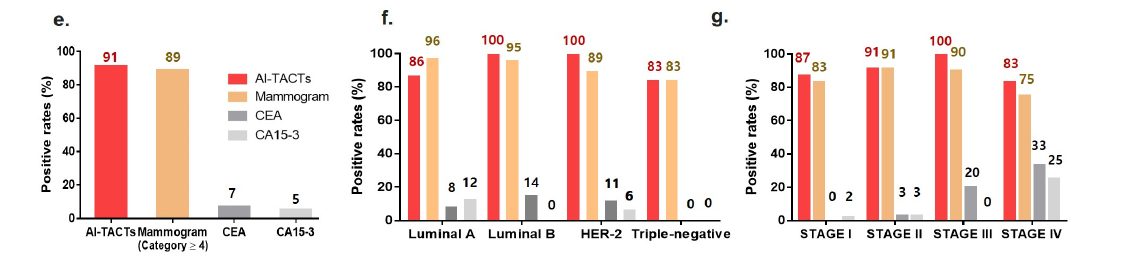
Figure 3. Modeling classifiers and validation of the TACT assay in healthy controls and breast can ‐ cer patients. ( a ) Optimization of artificial intelligence analyses (decision tree (DT), logistic regression (LR), artificial neural network (ANN), and support vector machine (SVM)) to model TACTs for dis ‐ tinguishing breast cancer patients from healthy controls. ( b ) Sensitivity and specificity of the ANN model in the training set. ( c ) Validation of TACTs using optimized DT, LR, ANN, and SVM. ( d ) Sensitivity and specificity of the ANN model in the test set. ( e ) Comparison of breast cancer posi ‐ tivity rates between the TACT assay and conventional breast cancer diagnostic methods (i.e., mam ‐ mograms and CEA/CA15 ‐ 3 blood markers). ( f ) Sensitivity of the TACT assay and conventional di ‐ agnostic methods for differentiating breast cancer subtypes. ( g ) Sensitivity of the TACT assay and conventional diagnostic methods for differentiating breast cancer stages. AUC, area under the re ‐ ceiver operating characteristic (ROC) curve.